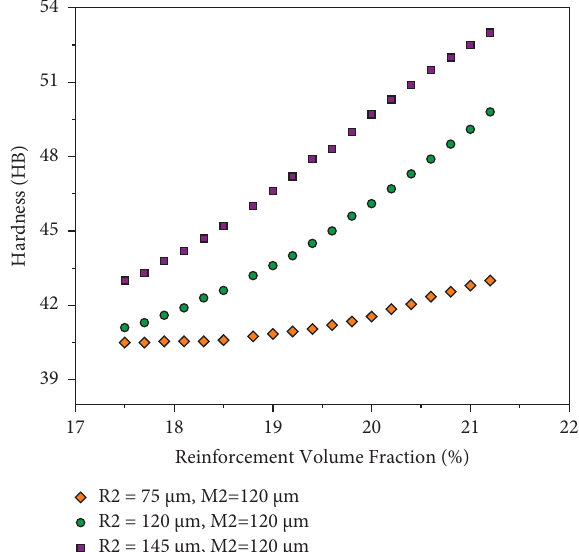
Figure 8: Composites with varied Rs/Ms ratios with varying